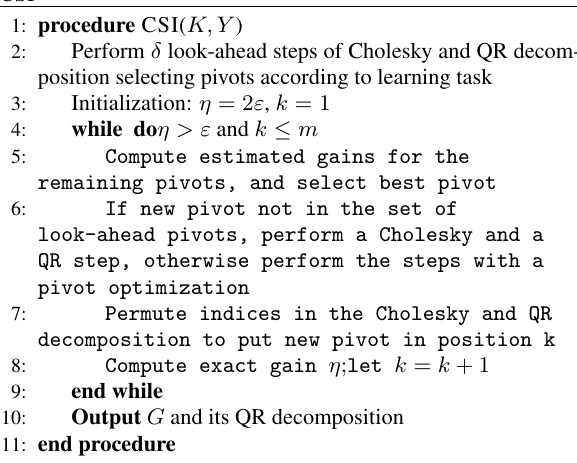
Algorithm 5 Cholesky decomposition with Side Information-